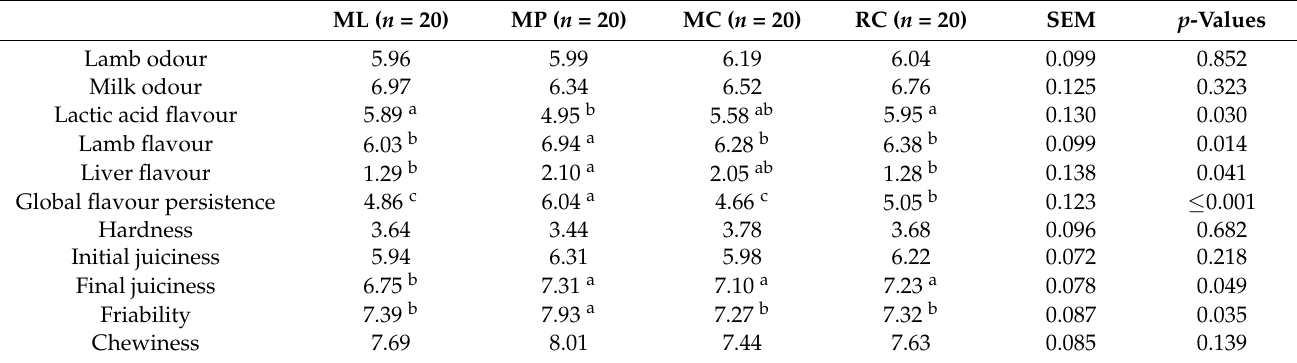
Table 5. Evaluations of sensorial analysis by trained panellists, for meat quality characteristics in Mal- lorquina lambs suckling (ML), grazing (MP), supplemented with grain (MC); and Roja Mallorquina lambs supplemented with grain